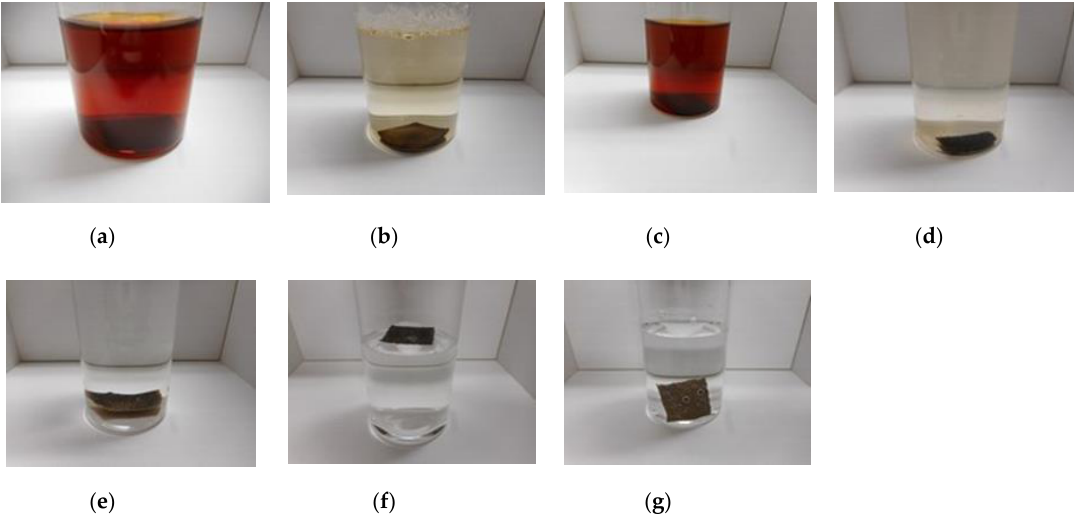
Figure 12. Images of single MCF rubber immersed in water; ( a ) NR-latex (Ulacol) by drying without a magnetic field; ( b ) NR-latex (Ulacol) by drying with a magnetic field; ( c ) NR-latex (Ulacol) by electrolytic polymerization with a magnetic field; ( d ) NR-latex (Ulacol) + CR-latex (671A) by electrolytic polymerization with a magnetic field; ( e ) NR-latex (Ulacol) + CR-latex (671A) + TiO 2 by electrolytic polymerization with a magnetic field; ( f ) NR-latex (Ulacol) + CR-latex (671A) + KE1300T + PVA by electrolytic polymerization with a magnetic field; ( g ) NR-latex (Ulacol) + CR-latex (671A) + KE1300T + PVA + TiO 2 by electrolytic polymerization with a magnetic field; all rubbers include MF (W-40) and